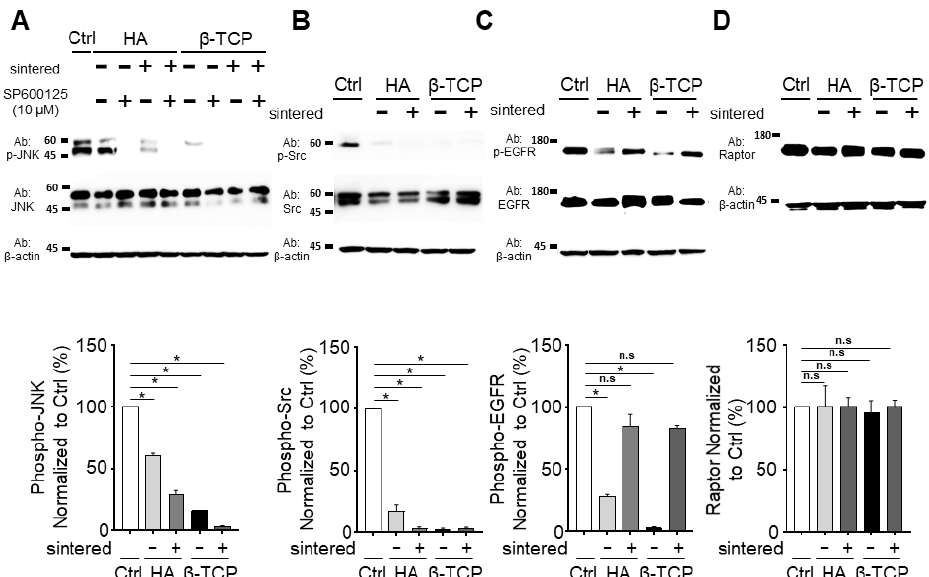
Figure 3. Western blotting measurements examining several intracellular signaling pathways of MG63 cells after exposure to the sintered and non-sintered bioceramics: ( A ) JNK/p-JNK; ( B ) Src/p- Src; ( C ) EGFR/p-EGFR; ( D ) Raptor. The bar graphs show values presented as the mean ± the SEM., which have been normalized to the control samples in each case. The results were compared using the one-way ANOVA method. * p < 0.05; n.s = not significant.